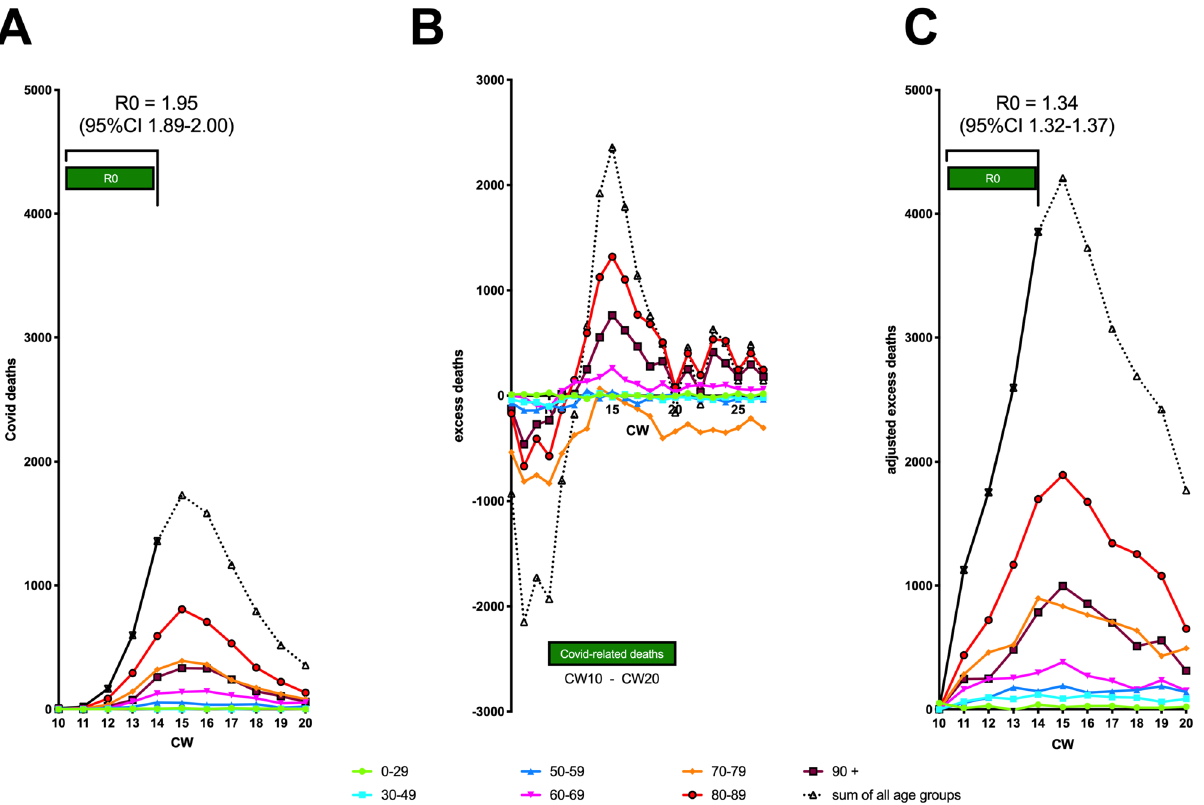
Figure 3. Calculation of R0 from excess mortality. ( A ) Covid-19 related deaths as weekly incidence in different age groups. ( B ) Excess deaths in 2020 in different age groups based on comparison with average weekly deaths in 2016–2019. ( C ) Excess deaths presented in B, but adjusted to 0 for week 10 in each age group, so that relative changes related to Covid-19 become better